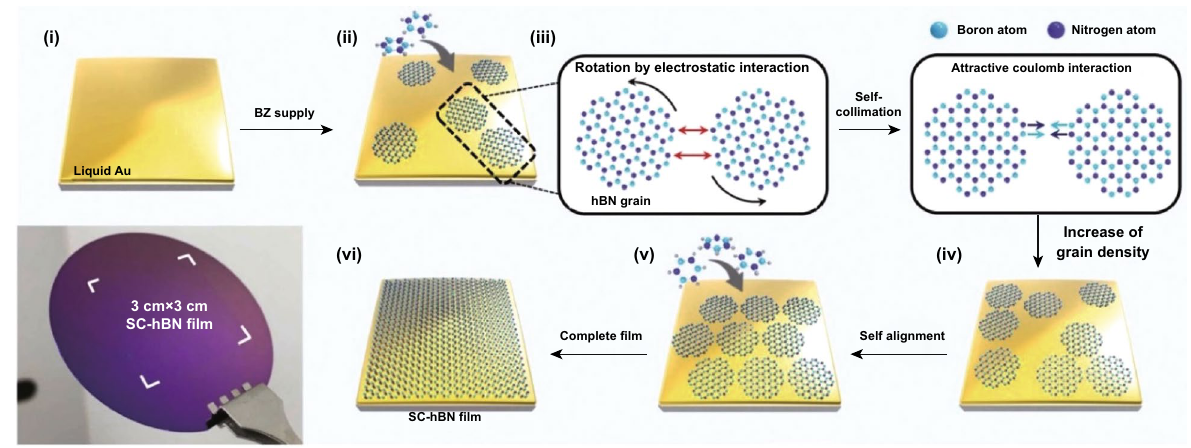
Fig. 5 Large-area CVD synthesised hBN. Sequential schematic of CVD single-crystal hBN growth of the self-collimated circular grains ( i – vi ). Grains rotate and align due to Coulomb interactions to form a single crystal, as shown in the photograph. Adapted with permission from